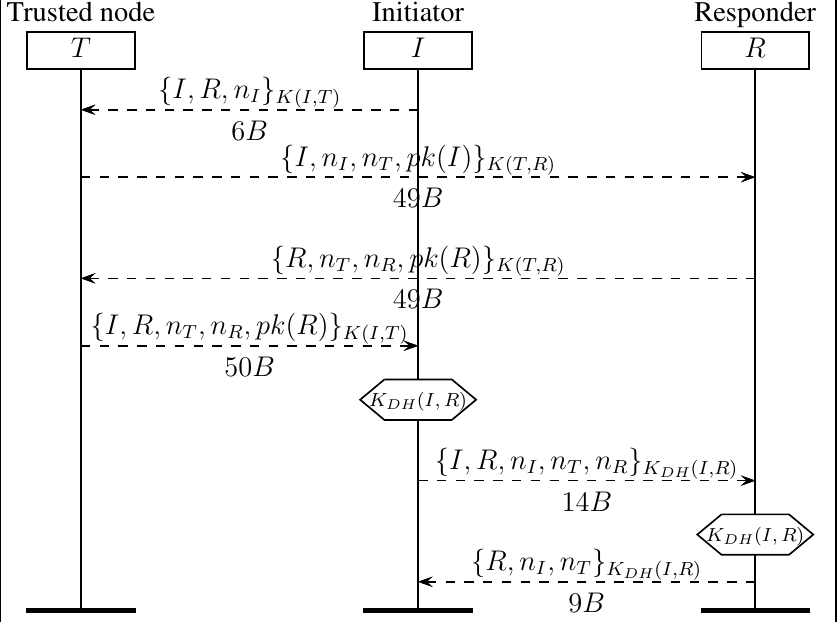
Figure 6. MKE − c : Multi-hop Key Establishment using a trusted node T to deliver public T keys. T possesses pk ( I ) but not pk ( R ) . K ( I, R ) is computed by the initiator I and the DH responder R